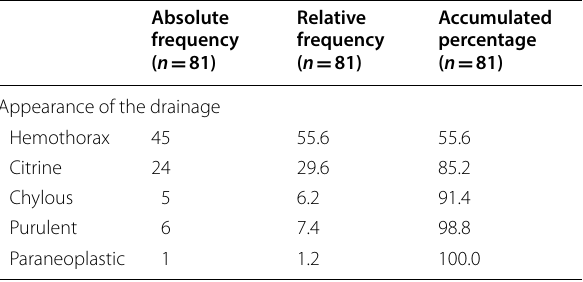
Table 3 Pre- and post-thoracentesis oxygenation parameters in the ICU patients PaO 2 /FiO 2 prior to the